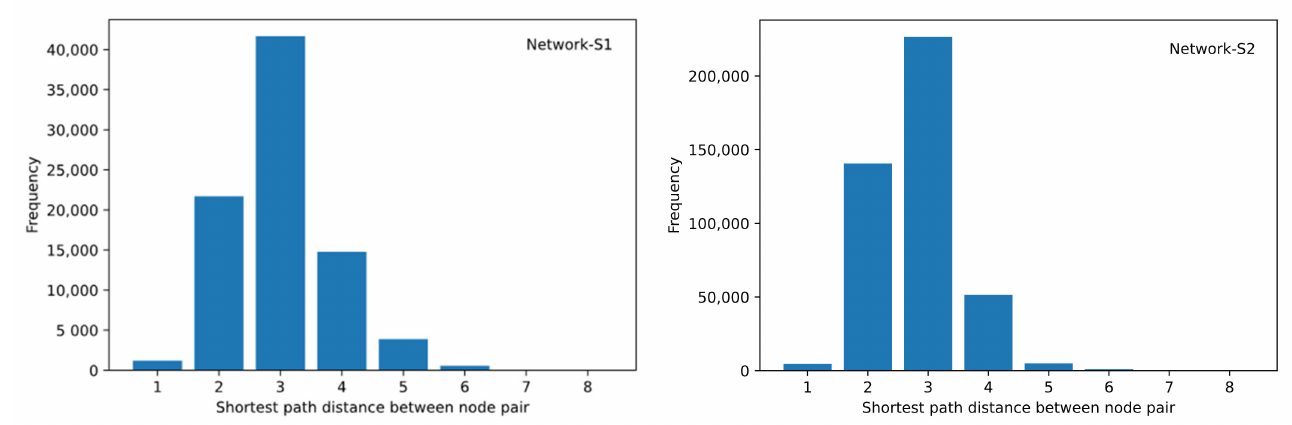
Figure 5. Shortcut distance distributions of the two networks.